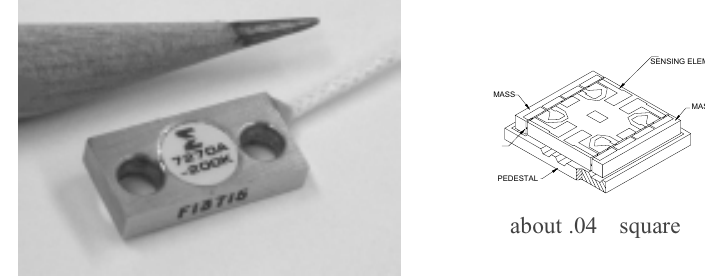
Fig. 12. Model 7270A accelerometer with MEMS flexure (right).